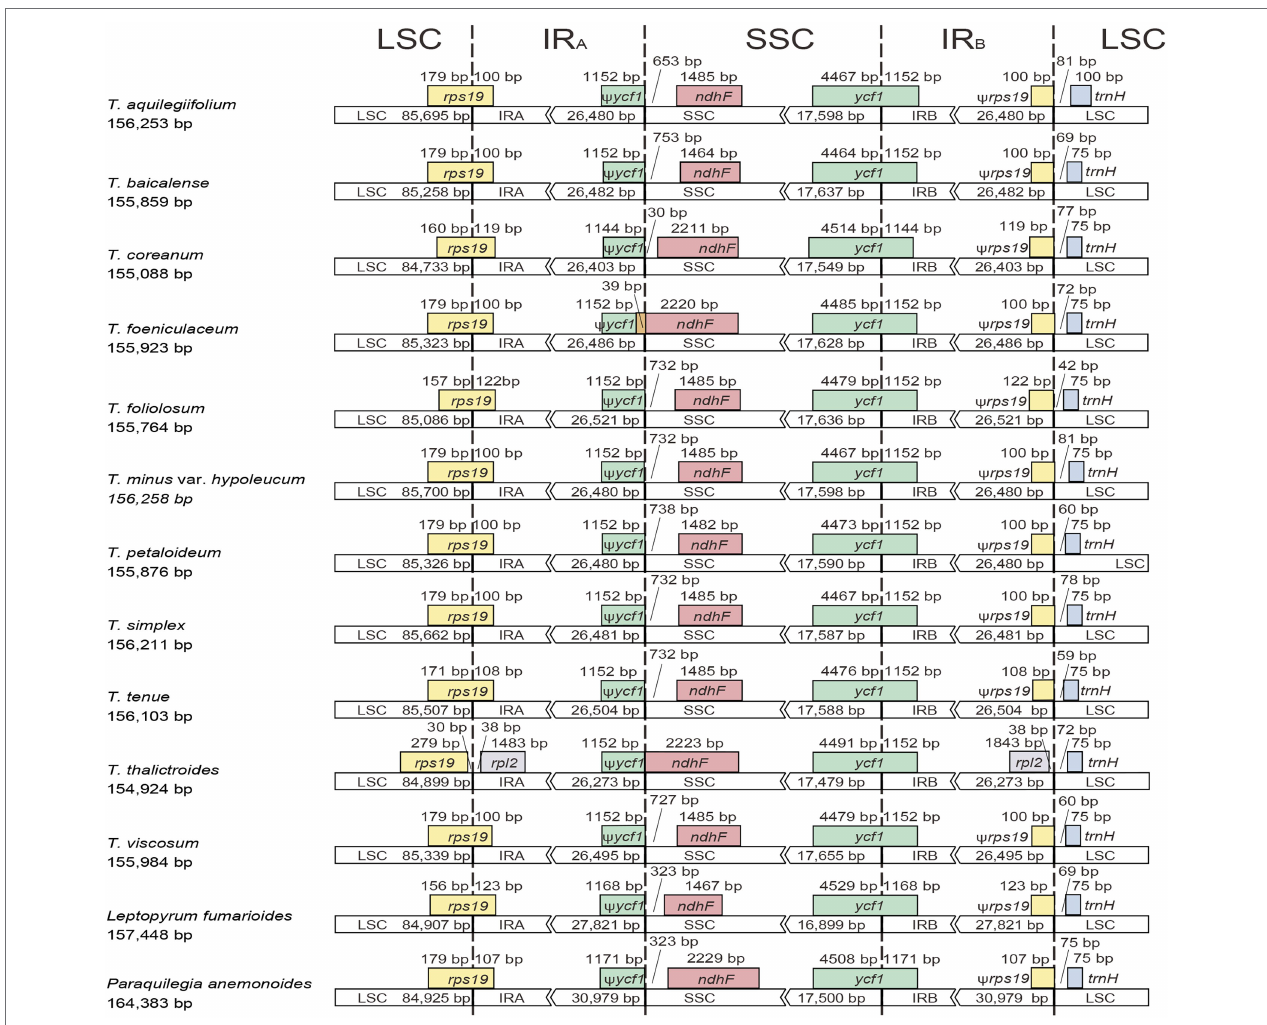
FIGURE 2 | Comparison of LSC, inverted-repeats (IRs), and SSC junction positions among Thalictrum